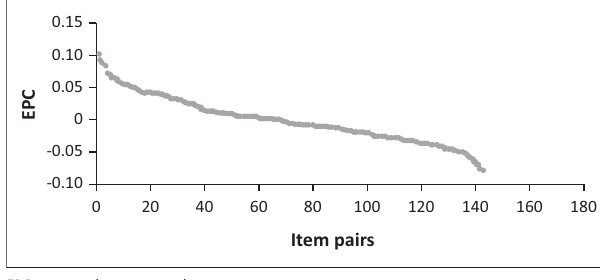
FIGURE 3: Ranked correlated residuals: One-factor model with eight method artefacts freed.